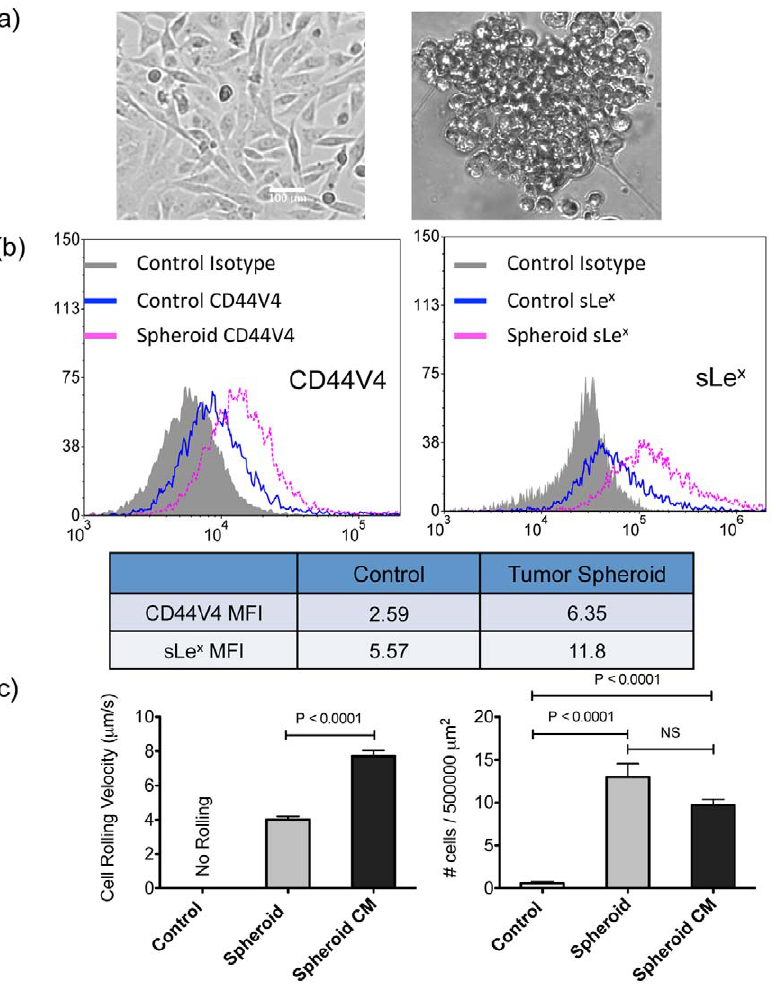
Figure 4. 3-D tumor spheroid culture further increases the interactions between BCa cells and E-selectin coated surfaces by upregulating CD44V4 and sLe x expression. (a) Micrographs of MDA-MB-231 cells cultured in 2-D monolayer (left) and 3-D spheroid on PDMS (right). (b) Flow cytometry results of CD44V4 (left) and sLe x (right) expression on untreated (2-D monolayer grown) and tumor spheroid cultured MDA-MB-231 cells. Tumor spheroid cultured cells were treated with enzyme free dissociation buffer prior to experiments to obtain mostly single cell populations. Mean fluorescence intensity ratio of sample over isotype has been included. (c) Average rolling velocity (left) and average number of MDA-MB-231 cells found interacting with E-selectin coated surfaces (right) cultured in medium (untreated), 3-D spheroid, and spheroid conditioned medium. Bars represent mean 6 SEM. Two-tailed unpaired student t-test was used. (d) CD44 mRNA expression of MDA-MB-231 cells that are cultured in control, IL-6, TNF- a , tumor spheroid, and plasma conditions, respectively, measured via qPCR.